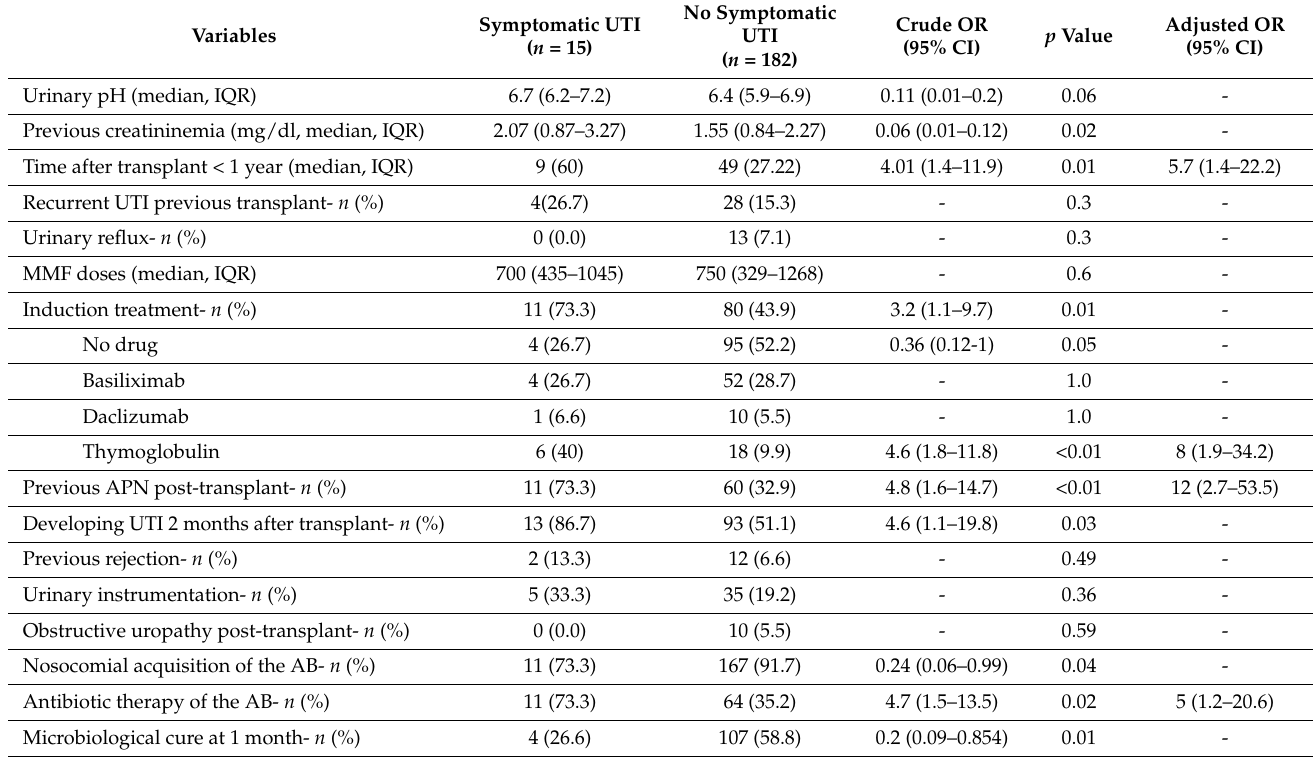
Table 4. Risk factors of symptomatic UTI during the 6 months of follow-up in patients with asymptomatic bacteriuria.